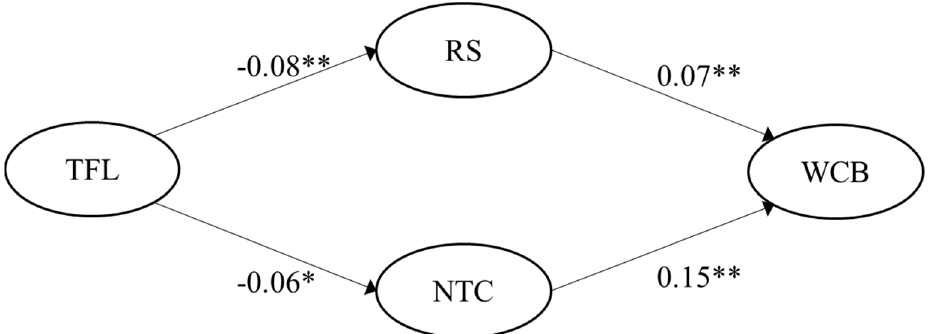
Figure 4. Empirical multiple mediation model for passive-avoidant leadership for the Spanish sample (n = 249). Note: ** indicates a p -value < 0.01; PAL = Passive-avoidant leadership; RS = Role stress; NTC = Negative team climate; WCB = Workplace cyberbullying.